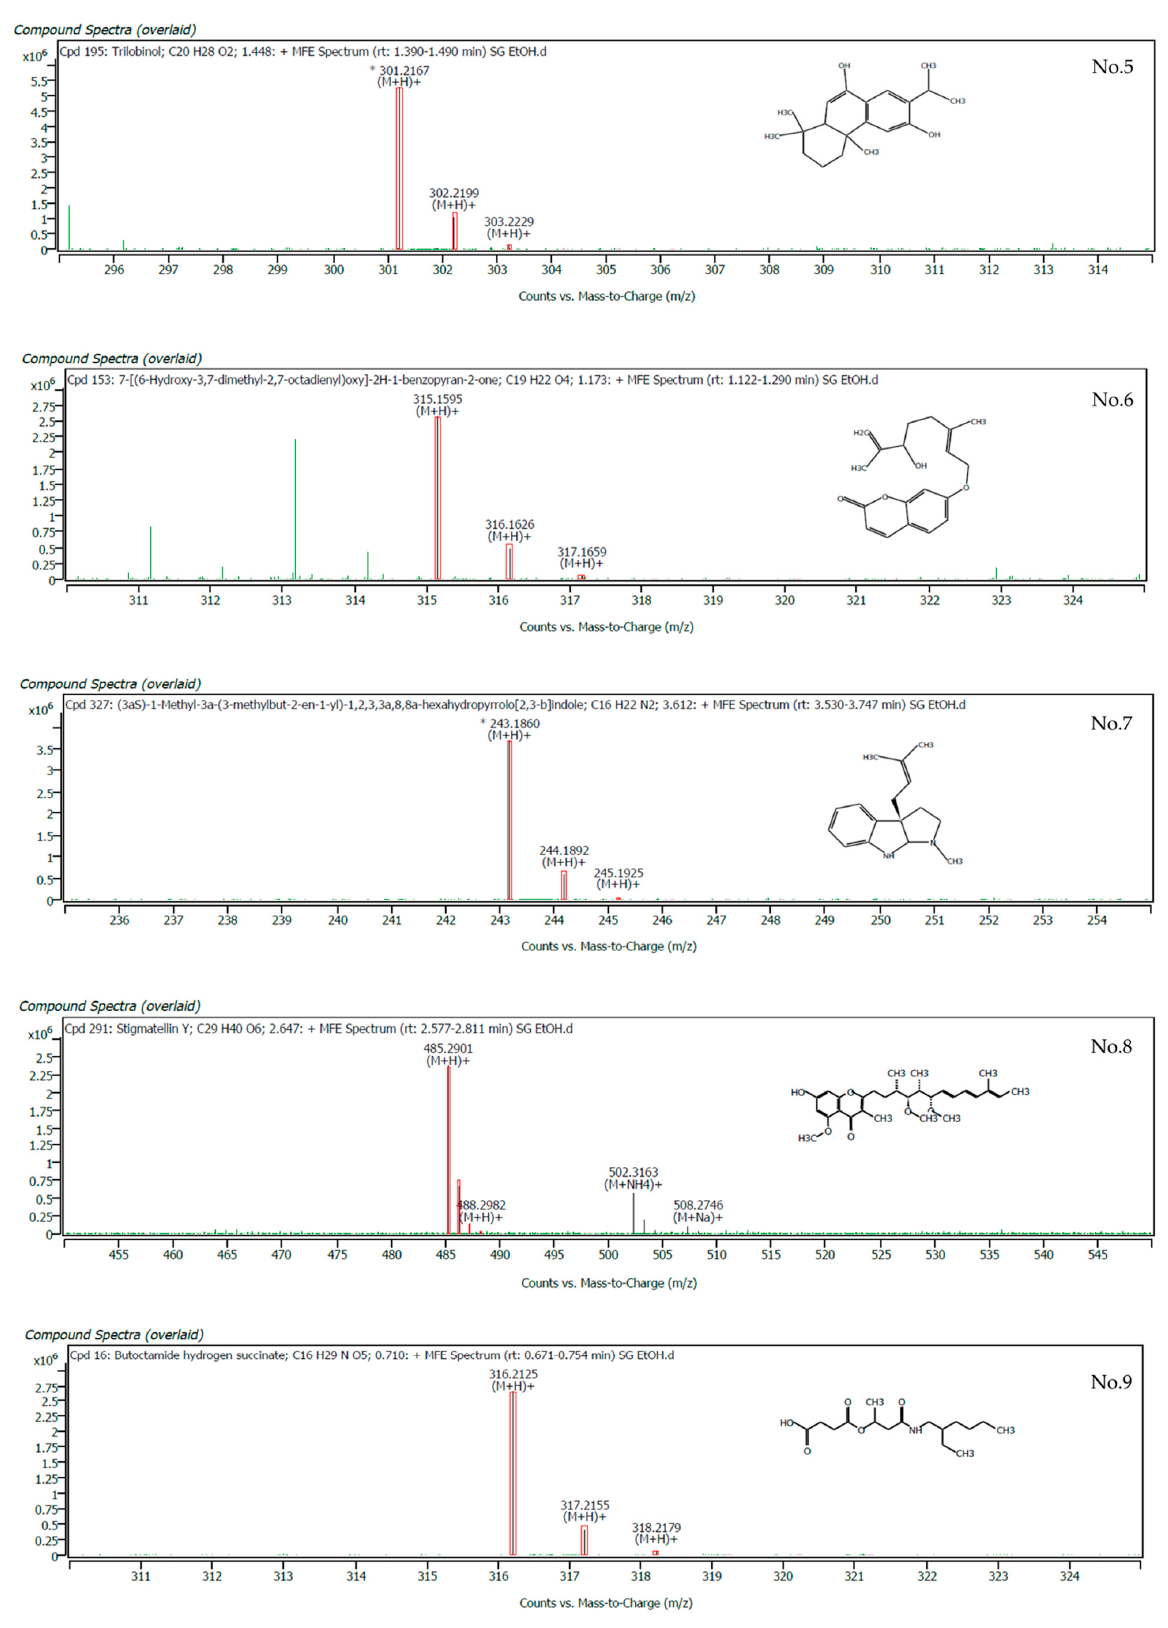
Figure 2. * LC-QTOF/MS analysis of the top ten compounds in terms of matching scores of S. glabra ethanolic crude extract: ( A ) LC-OTOF-MS chromatogram; ( No. 1 ) mass spectrum of CAY10435; ( No. 2